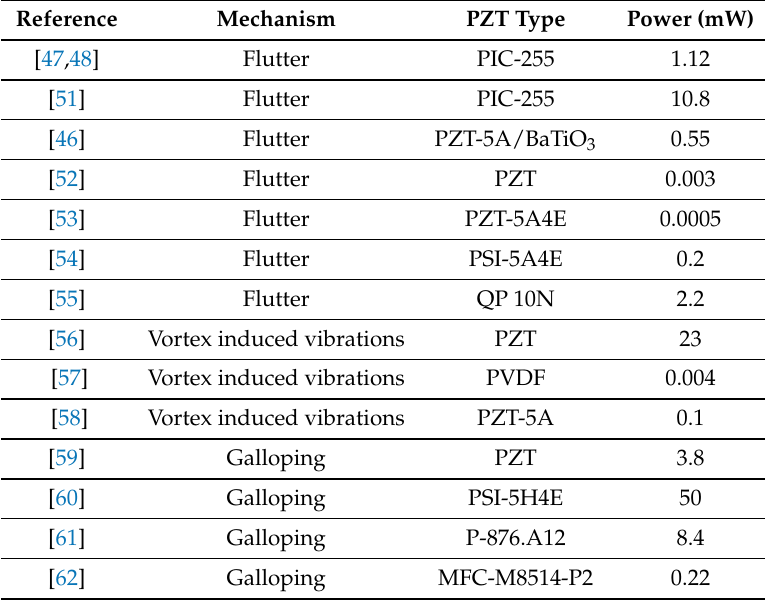
Table 1. Power comparison of various aeroelastic energy